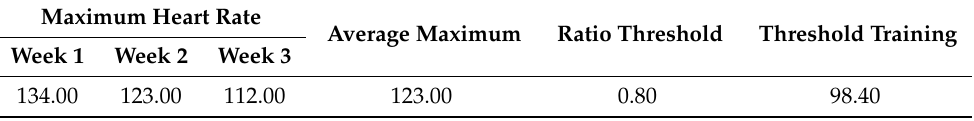
Table 7. Parameters for determining a threshold training during second